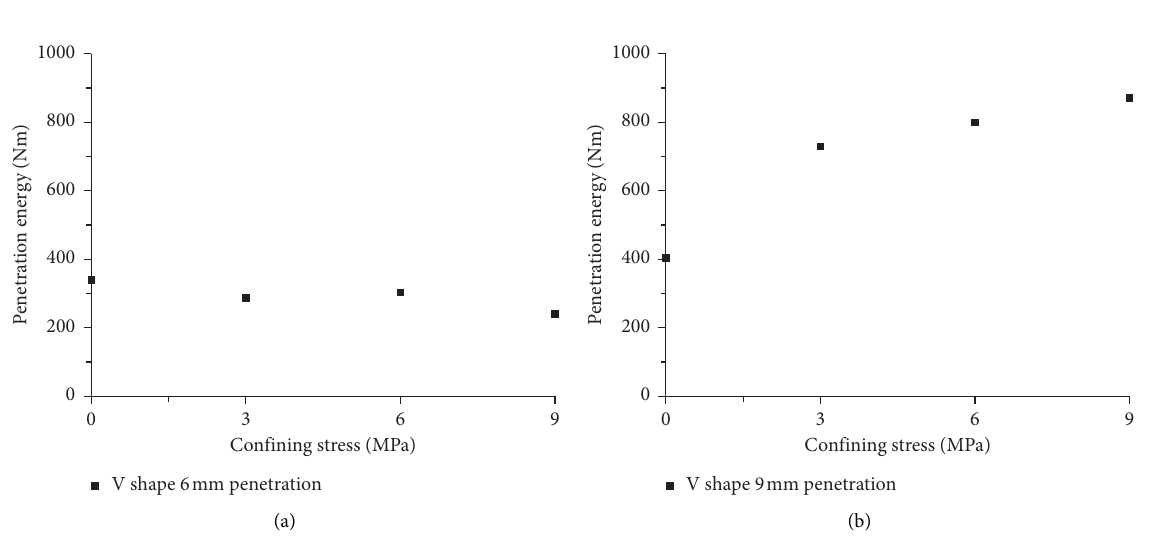
Figure 16: Penetration energy varies with confining stresses under V shape disc cutter. (a) Ultimate penetration � 6mm; (b) ultimate penetration �